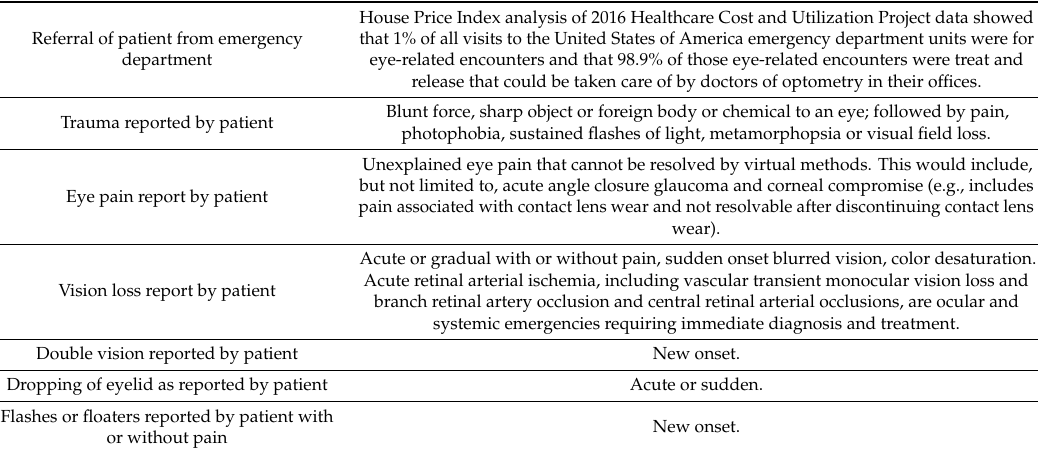
Table 1. Examples of essential care requiring emergency o ffi ce